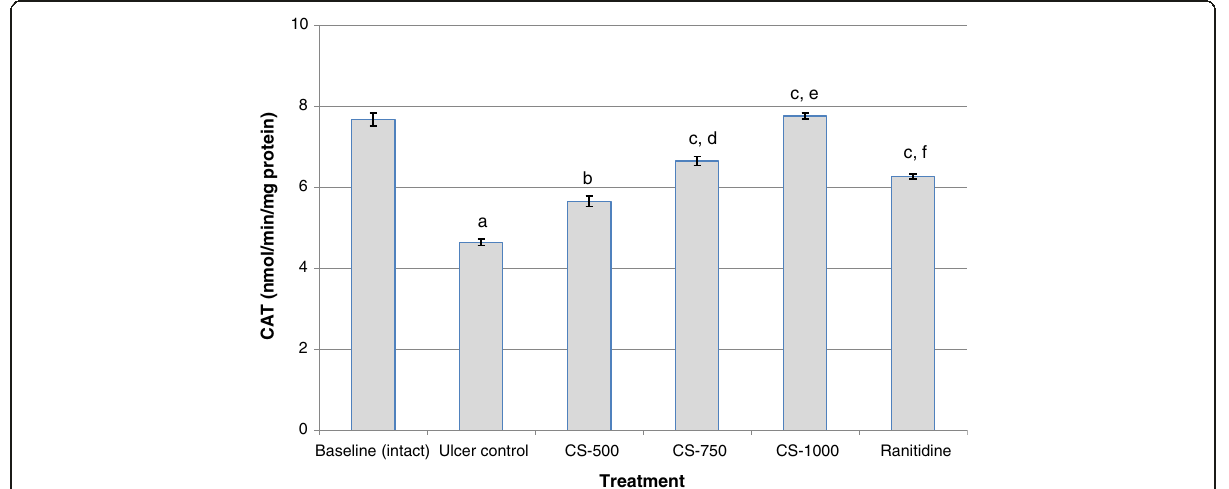
Figure 4 Effect of C. sieberiana (CS) plant extract on mucosal catalase activity in F 344 rats. a p<0.001 compared with baseline (intact); b p<0.01 compared with ulcer control; c p<0.001 compared with ulcer control; d p<0.01 compared with CS-500; e p<0.001 compared with CS-750; f p<0.001 compared with CS-1000; Values are Mean ± SEM of 6 animals. Statistical significance was determined by one-way analysis of variance (ANOVA) followed by Dunnett ’ s post hoc t